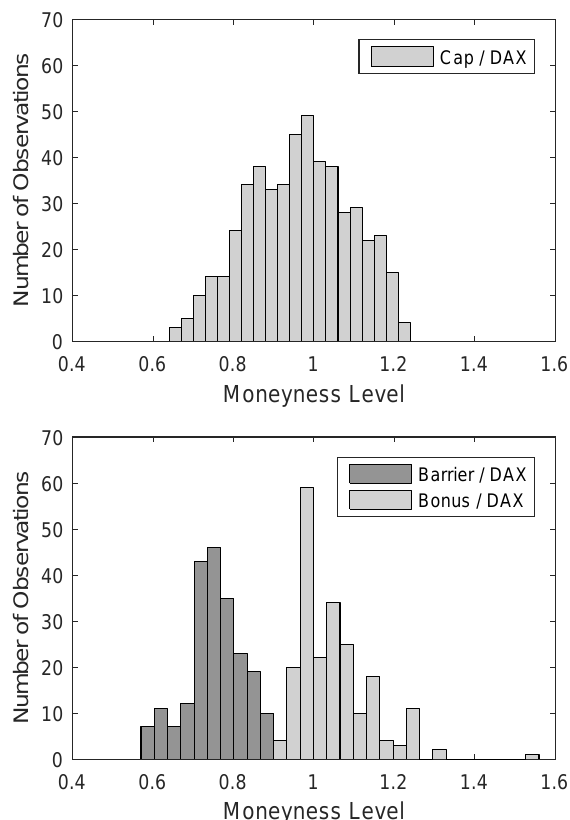
Figure A2. Histogram of Cap, Bonus and Barrier Moneyness. For all discount certificates, we divide the cap value by the end-of-day DAX level at issuance to obtain the “moneyness” of the embedded call option. Correspondingly, we do so for capped bonus certificates with the barrier and bonus level. The upper histogram corresponds to discount certificates and the lower to capped bonus certificates, respectively.